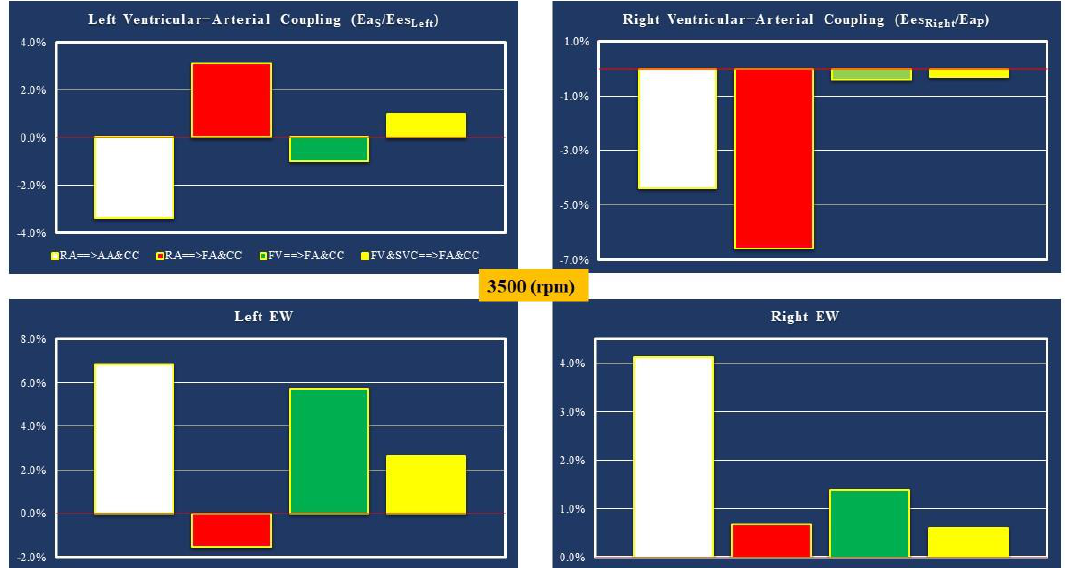
Figure 10. The top-left ( right ) panel shows the relative changes in left (right) ventricular–arterial coupling Ea S /Ees Left (Ea P /Ees Right ) for different cannulations applied with pump rotational speed set to 3500 rpm. The relative changes estimate with respect to baseline conditions of the energetic variable (EW) for the left (right) ventricle is reported in the bottom-left ( right ) panel . An increase in Ea S /Ees Left (top-left panel) for both RA → FA&CC and FV&SVC → FA&CC cannulations was observed when the pump rotational speed was set to 3500 rpm. On the contrary, the right ventricular – arterial coupling showed a percentage reduction compared to the baseline values for all types of cannulations (top-right panel). Only the RA → FA&CC cannulation configuration underwent a reduction in left ventricular EW of less than 2%. An EW increase of up to 7% was observed for the RA → AA&CC cannulation method (bottom-left panel). When the pump speed was set to 3500 rpm, a modest per- centage increase in right ventricular EW compared to baseline conditions (bottom right panel) was observed for all the cannulation configurations. An analysis of the percentage changes in left ventricular EW (right ventricular PVA) for FV → FA&CC, FV&SVC → FA&CC and RA → AA&CC cannulation configurations when the pump rotational speed was set to 2000, 2500, 3000, 3500, 4000 and 4500 rpm is shown in the top-left (right) panel of Figure 11. When the pump speed was set to 4500 rpm, an increase of more than 15% in left ventricular EW and about 25% in right ventricular PVA was observed for the RA → AA&CC cannulation configuration.